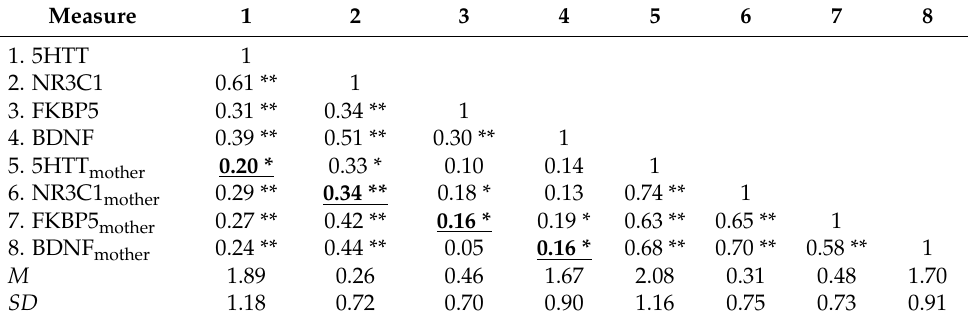
Table A1. Correlations, means, and standard deviations of the key variables.